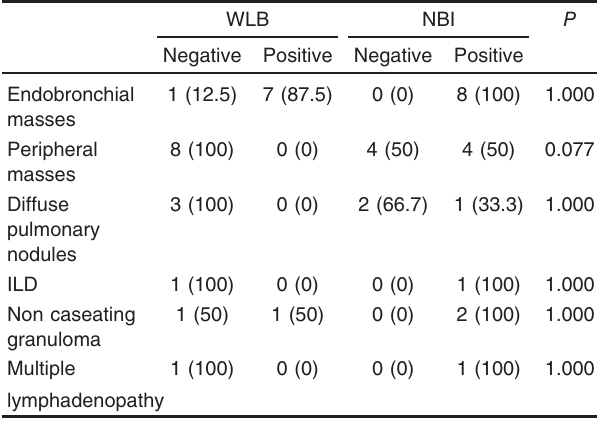
Qualitative data were described using n (%) and was compared using the χ 2 or the Fisher exact test. ILD, interstitial lung fibrosis; NBI, narrow band imaging; WLB,